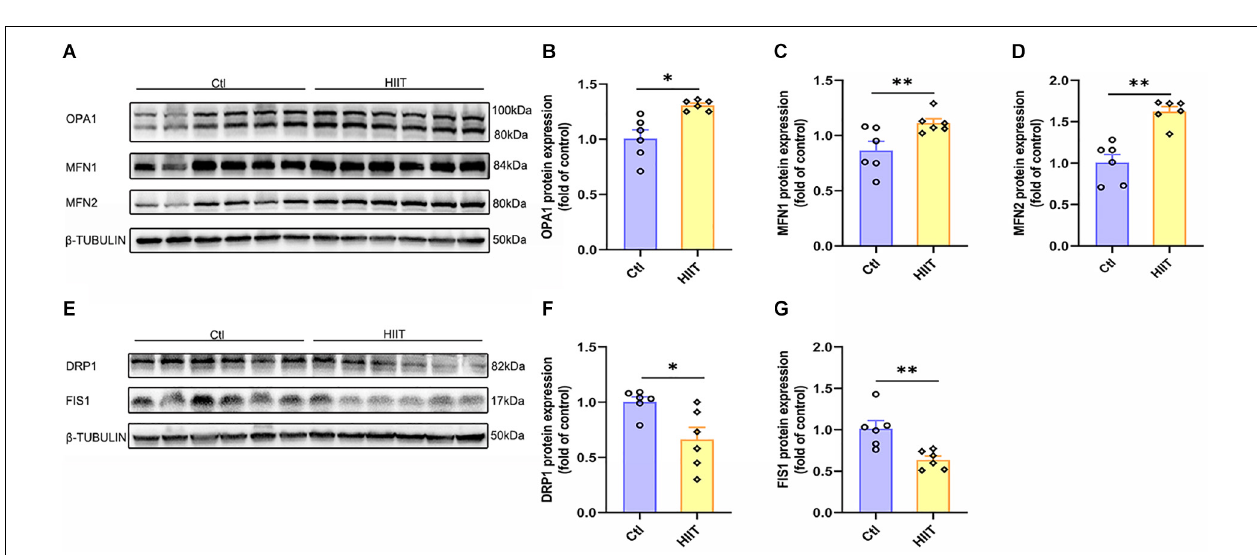
FIGURE 4 | The effects of HIIT on hippocampal mitochondrial fusion and fission. The Optic atrophy (OPA1), Mitofusin 1 (MFN1), and Mitofusin 2 (MFN2) were determined by WB to represent the mitochondrial fusion state in mouse hippocampus. The Dynamin-related protein1 (DRP1) and mitochondrial fission 1 protein (FIS1) were also determined by WB to represent the mitochondrial fission state in mouse hippocampus. (A,E) Representative WB image. (B) OPA1 protein expression. (C) MFN1 protein expression. (D) MFN2 protein expression. (F) DRP1 protein expression. (G) FIS1 protein expression. TUBULIN as the loading control. N = 6 mice per group. ∗ p ≤ 0.05 and ∗∗ p ≤ 0.01 as compared with the Ctl group by unpaired Student’s t test. Values are expressed as mean ± standard error of the